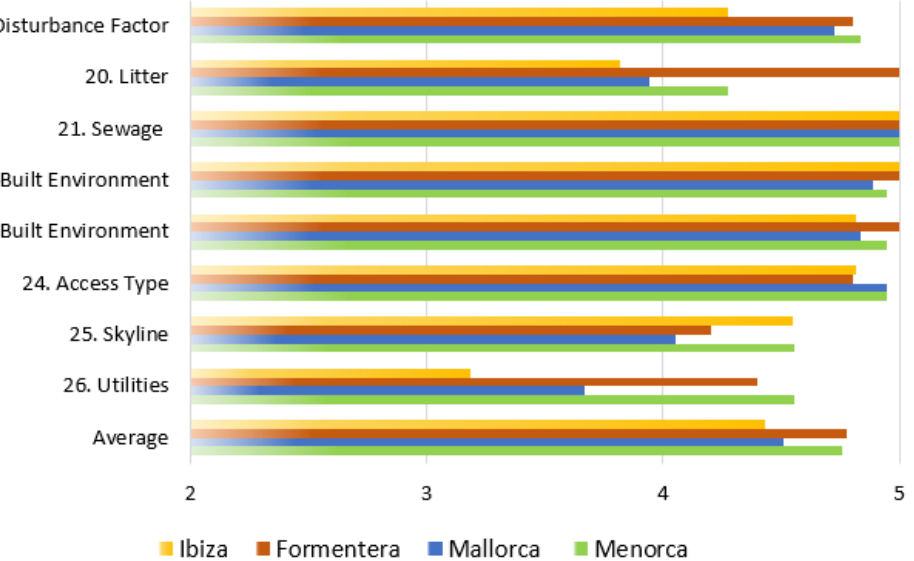
Figure 9. Comparison of human parameters values between islands.